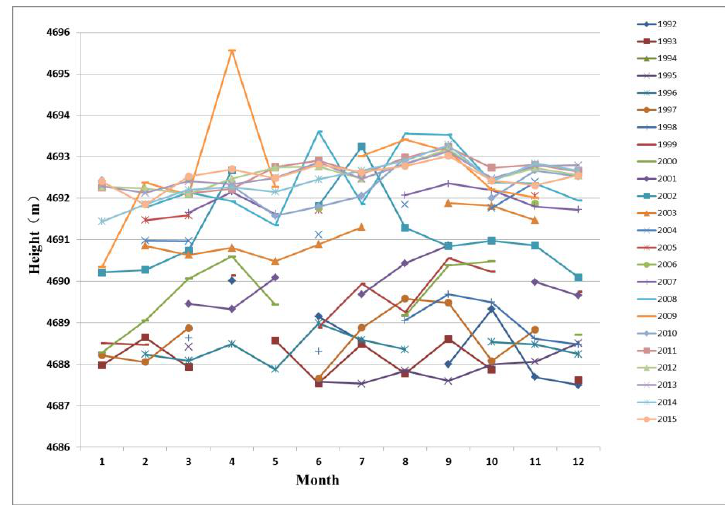
Figure 5. Intra-annual analysis of lake height from 1992 to 2015